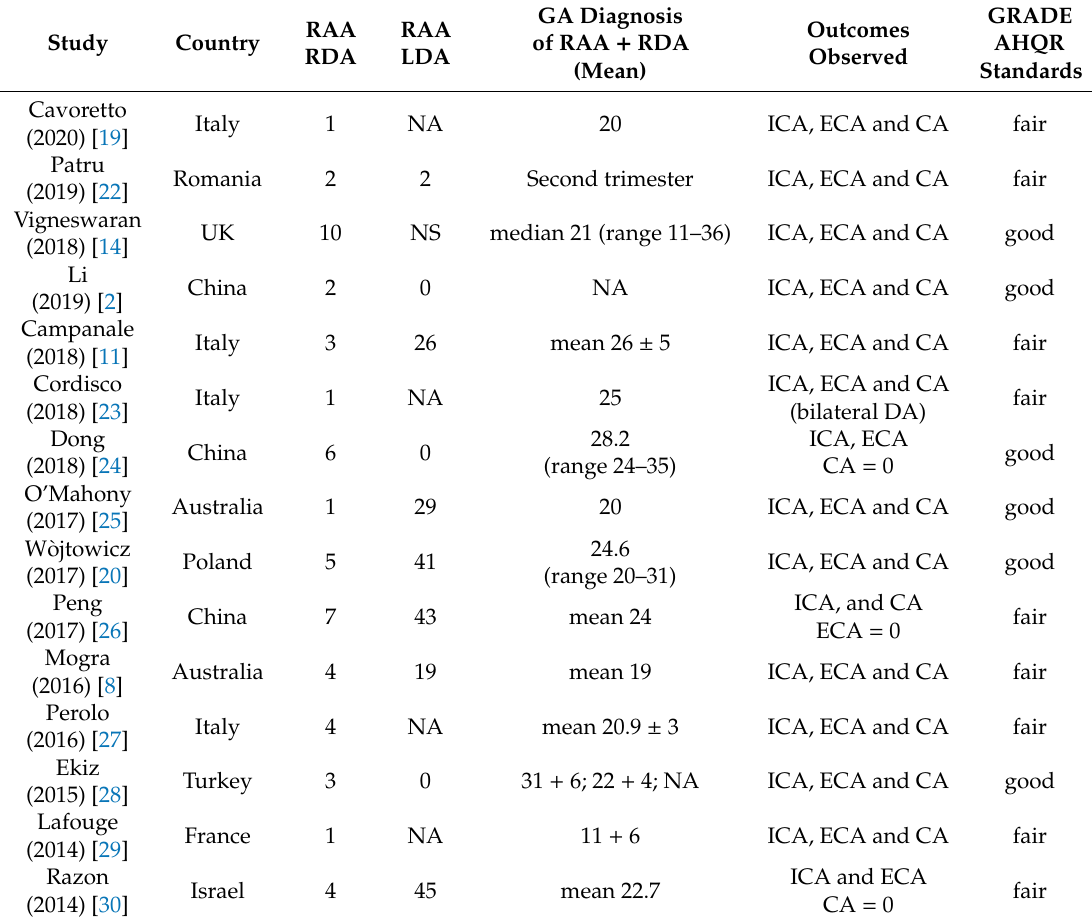
Table 1. Study characteristics, outcomes, and quality